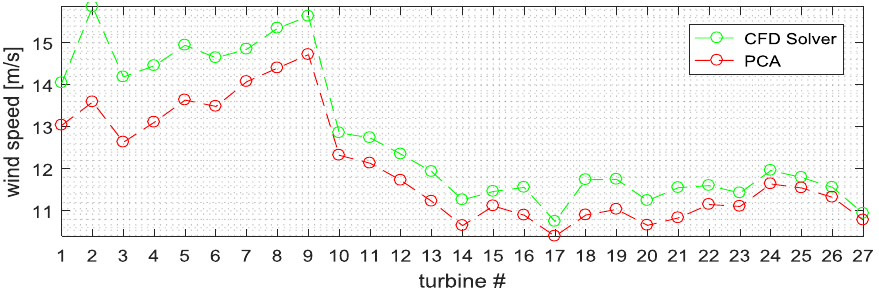
Figure 6. Comparison between spatial wind speed obtained from CFD solver output (green) and obtained by using of the PCA-CBR for the 2nd hour forecasting.